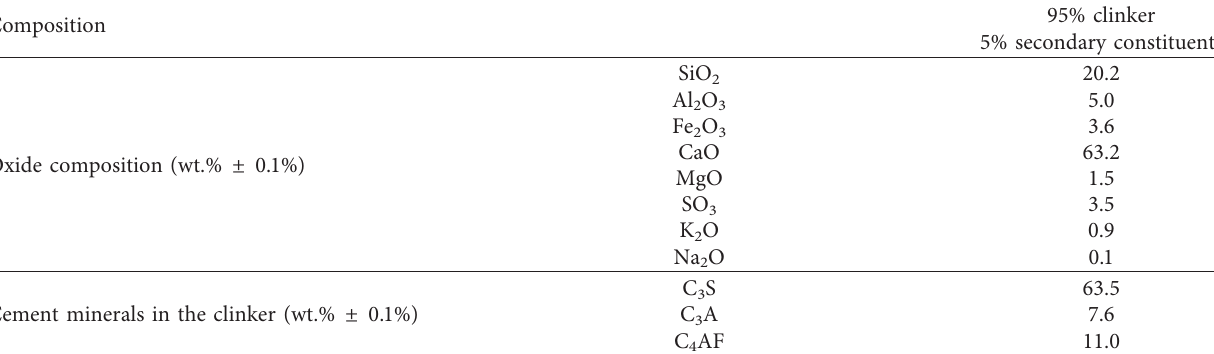
Table 2: Chemical composition of normal Portland cement: CEM I 52.5 N CE CP2